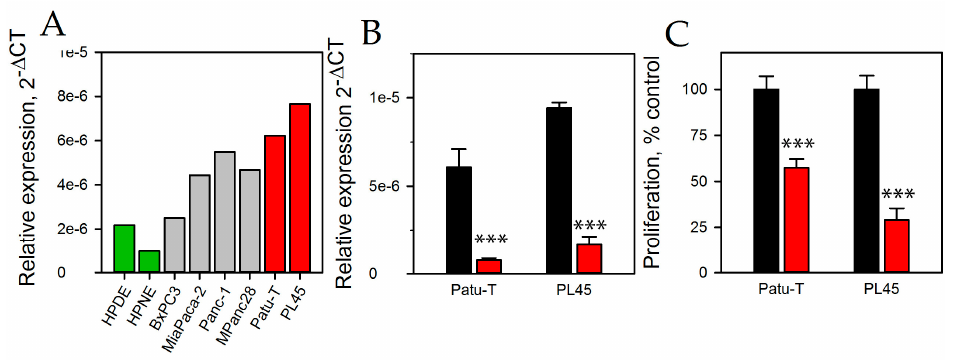
Figure 2. ( A ) qPCR was used to determine the relative expression of HNRNPU processed transcript in immortalized pancreas epithelial cell lines (green bars) and PDAC cell lines (grey and red bars). Patu-T and PL45 cells (red bars) were used in the remainder of the study. ( B ) Relative expression of HNRNPU processed transcript as determined by qPCR in Patu ‐ T and PL45 cells following a 48 h exposure of 100 nM of control LNA TM gapmer (black bars) or LNA gapmer to HNRNPU processed transcript (red bars). Data were normalized to 18 S rRNA. ( C ) Cell proliferation was determined using a WST1 assay in Patu ‐ T and PL45 cells following a 48 h exposure of 100 nM of control LNA gapmer (black bars) or LNA gapmer to HNRNPU processed transcript (red bars). *** p < 0.001.